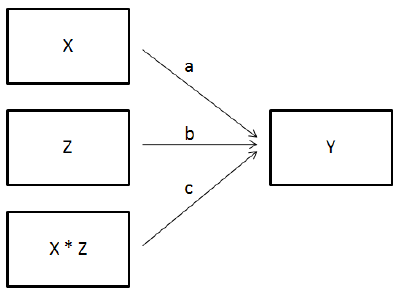
Figure 5. Standard variable-based moderation